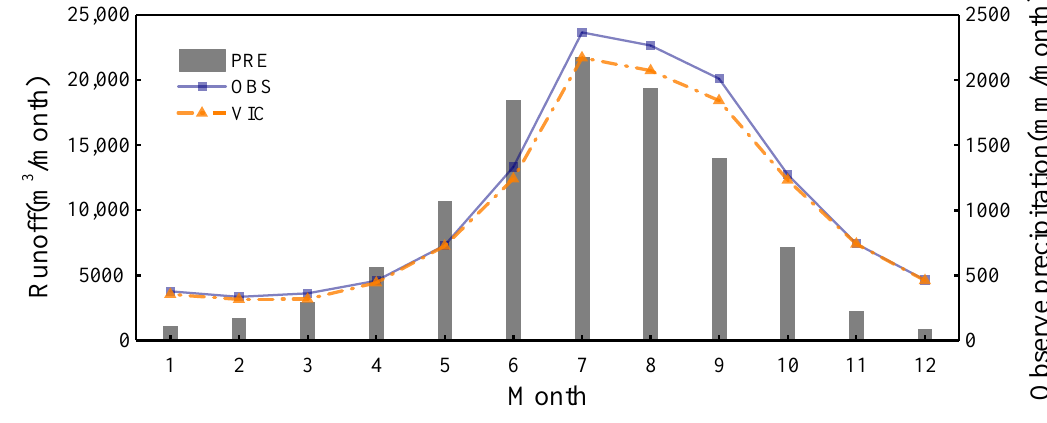
Figure 7. Comparison of monthly accumulated average runoff.